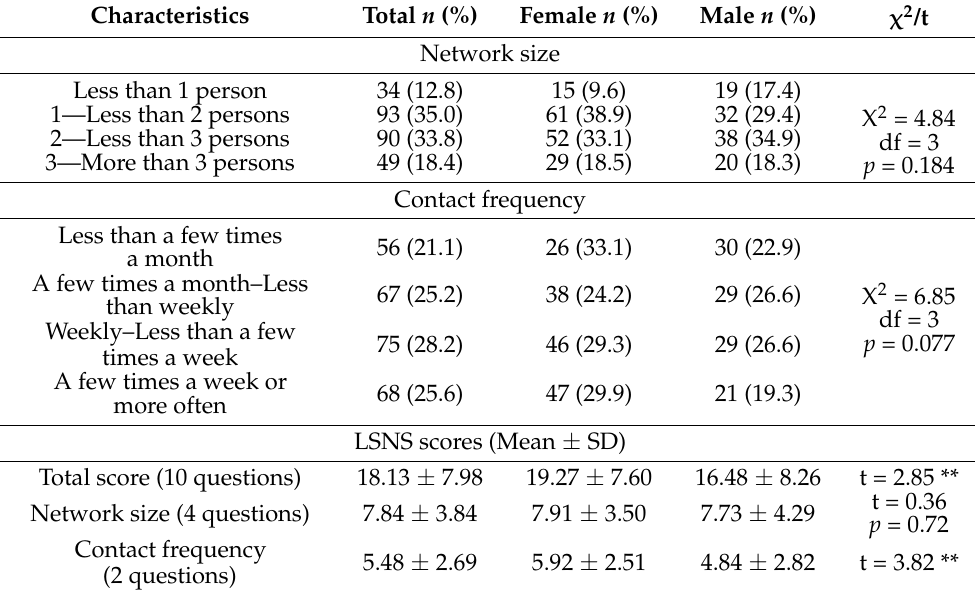
Table 2. Characteristics of participants’ social network ( n =